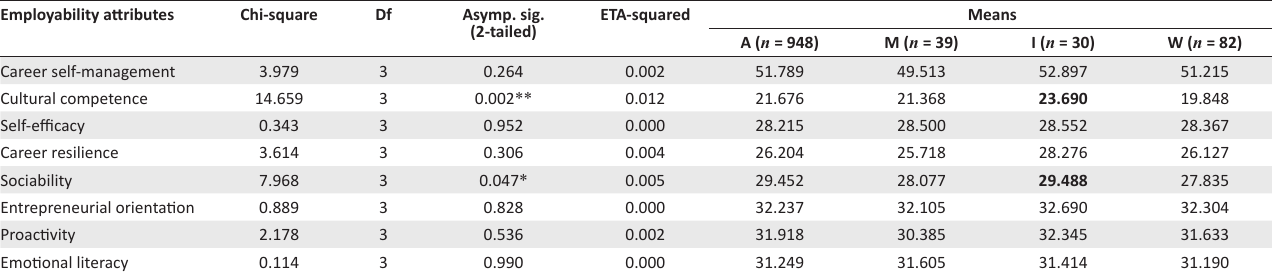
TABLE 3: Differences in employability attributes with regard to race. Employability attributes